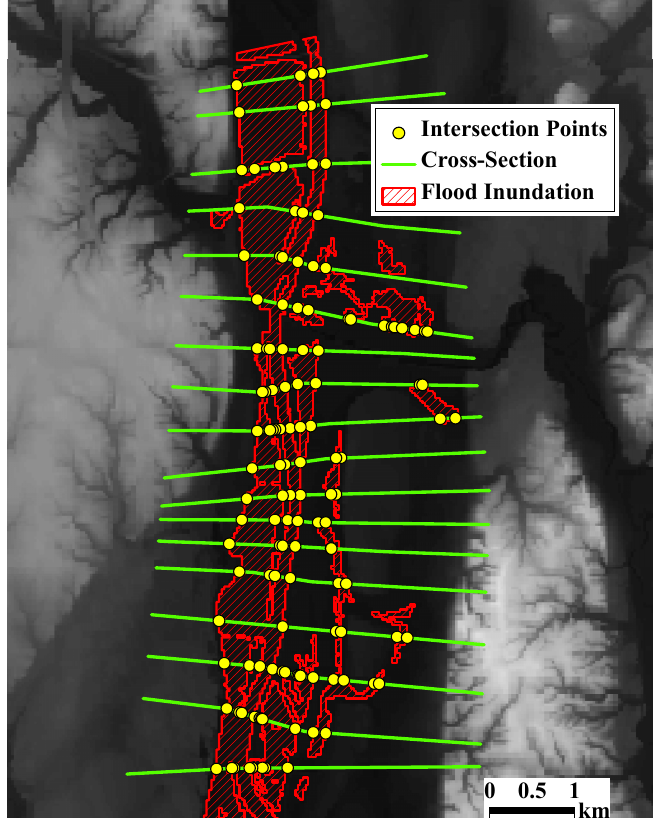
Figure 5. Intersection points for estimating the rating equations (the Montezuma reach, 11 April